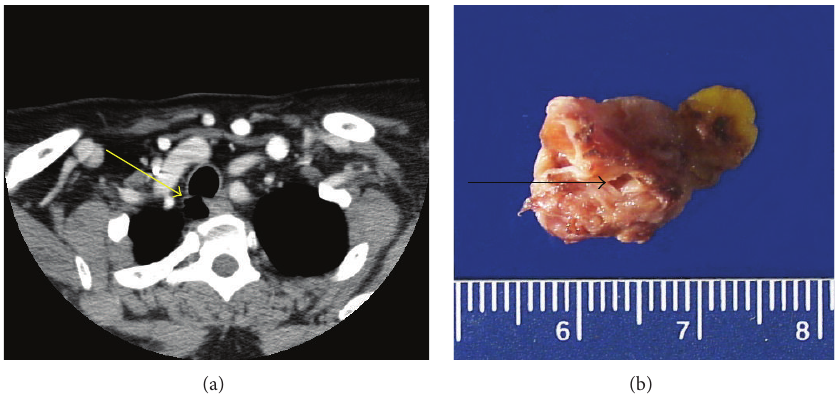
Figure 1: CT scan of the neck w/contrast showed a right paraesophageal air-filled diverticulum extending from the trachea (a). Grossly the specimen consisted of a 2.4 × 1.5 × 0.8 cm tan brown cystic structure with an opening of 0.2 cm in diameter (marked by arrow) and attached adipose tissue (b).